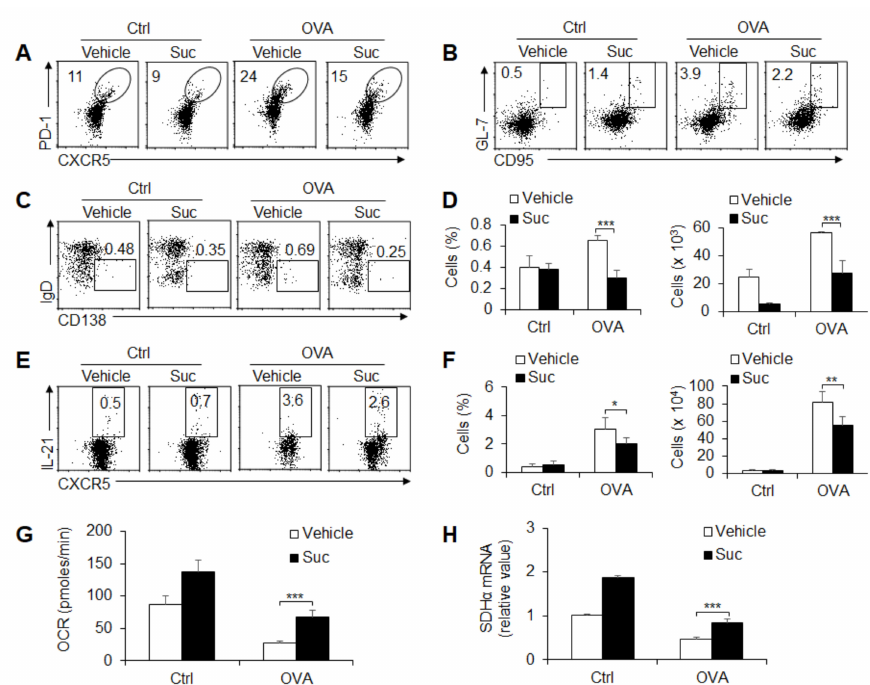
Figure 5. OXPHOS signaling controls T FH cell di ff erentiation induced by foreign antigens. WT mice underwent intraperitoneal immunization with OVA plus LPS in alum and in the presence of PBS (vehicle) or succinate (Suc, 70 mg / kg / day) i.p. at 8 days, and mouse spleens were isolated for analysis. ( A ) Flow cytometry of T FH cells in spleens. ( B ) Flow cytometry of GC B cells in spleens. ( C , D ) Flow cytometry analysis of plasma cells ( C ) and the frequency and number of plasma cells are shown ( D ). ( E , F ) Flow cytometry analysis of IL-21 + CXCR5 + PD1 + CD4 + T FH cells in spleens ( E ). The frequency and the number of IL-21 + T FH cells are shown ( F ). ( G ) OCR was analyzed as a readout for OXPHOS in T FH cells sorted from splenocytes. ( H ) Sdh α mRNA expression was analyzed by real-time PCR in CD4 + T FH cells sorted from splenocytes. Data are representative of three individual experiments (n = 4–5 mice per group). *** p < 0.001, compared with the indicated